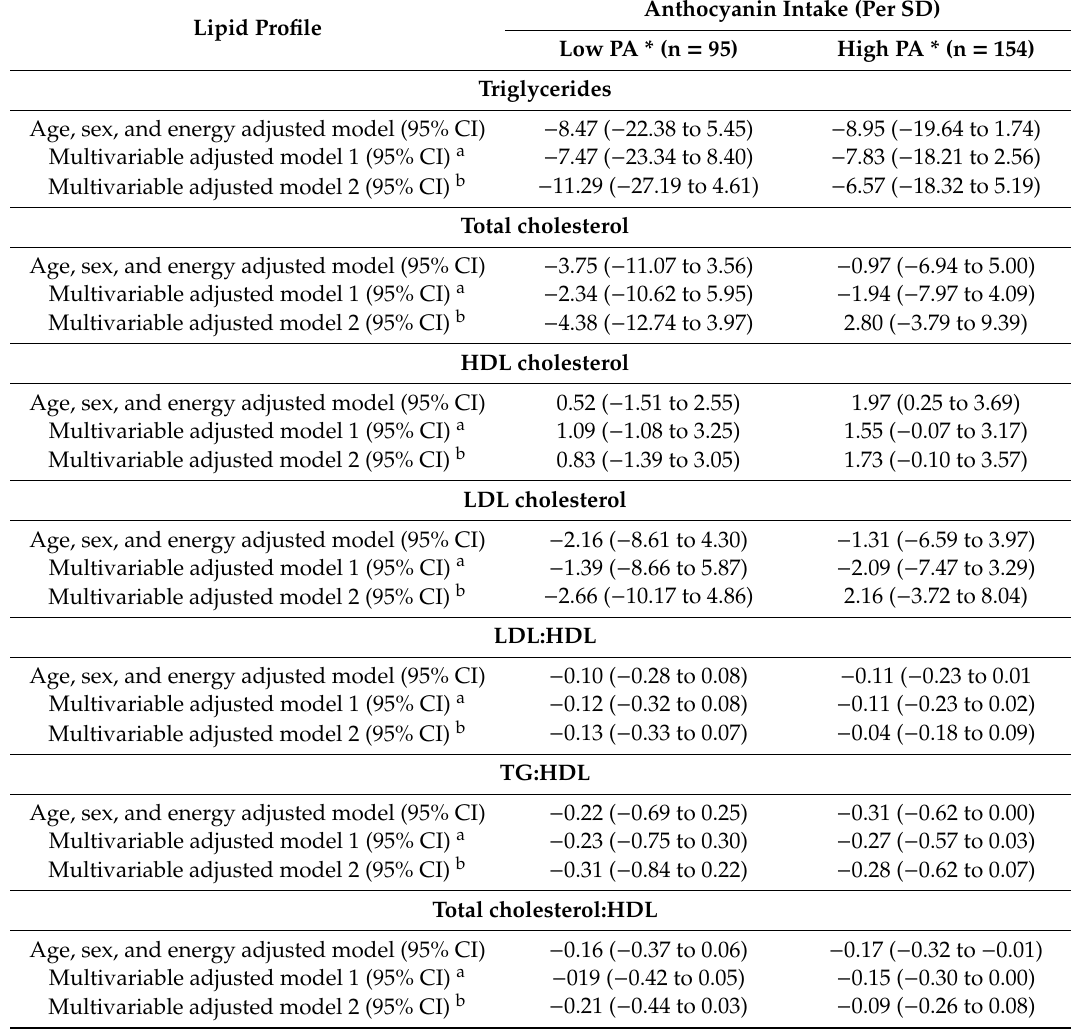
Table 3. Association ( β , 95% CI) between anthocyanin intake (independent variable in SD units) and di ff erent lipid parameters (mg / dL) stratified by subgroups of low and high physical activity